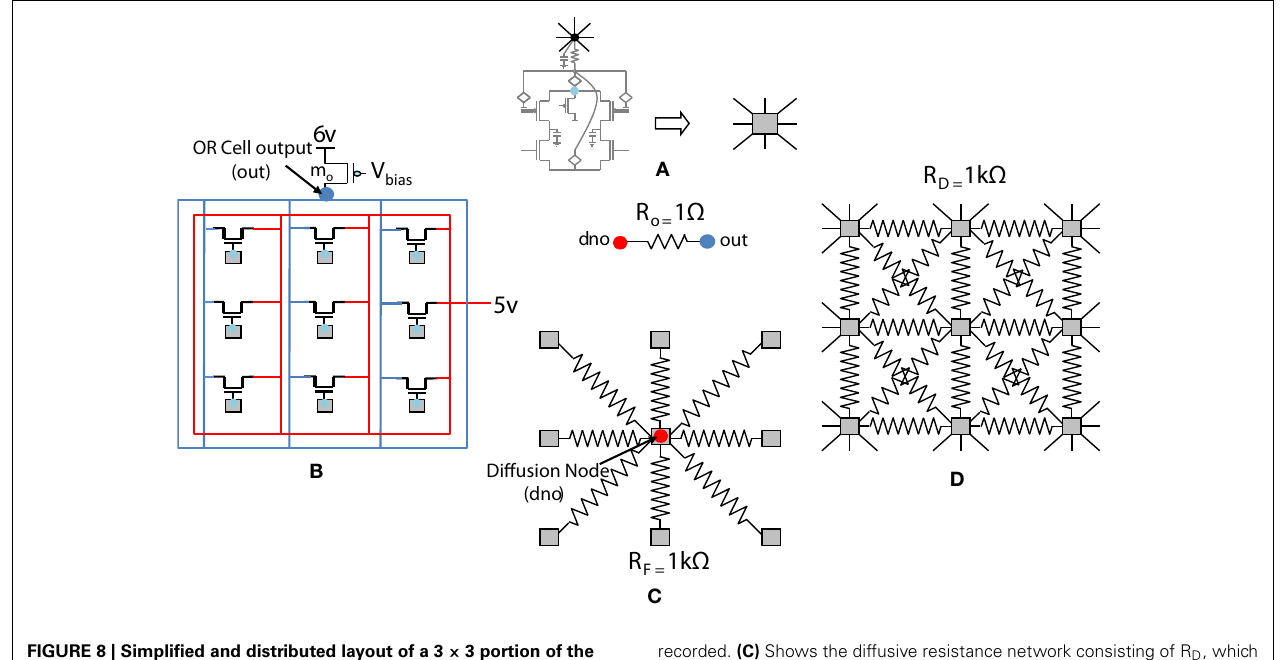
recorded. (C) Shows the diffusive resistance network consisting of R D , which connects the ts-WTA cells to all their neighbors. (D) Shows the feedback resistive network consisting of R F that feeds the output of the cell from dno back to the individual ts-WTAs. Out and dno are connected by R o which can be replaced by a buffer device discussed in section 5.2. (see Figure 5 for the lateral view, this is a top view).